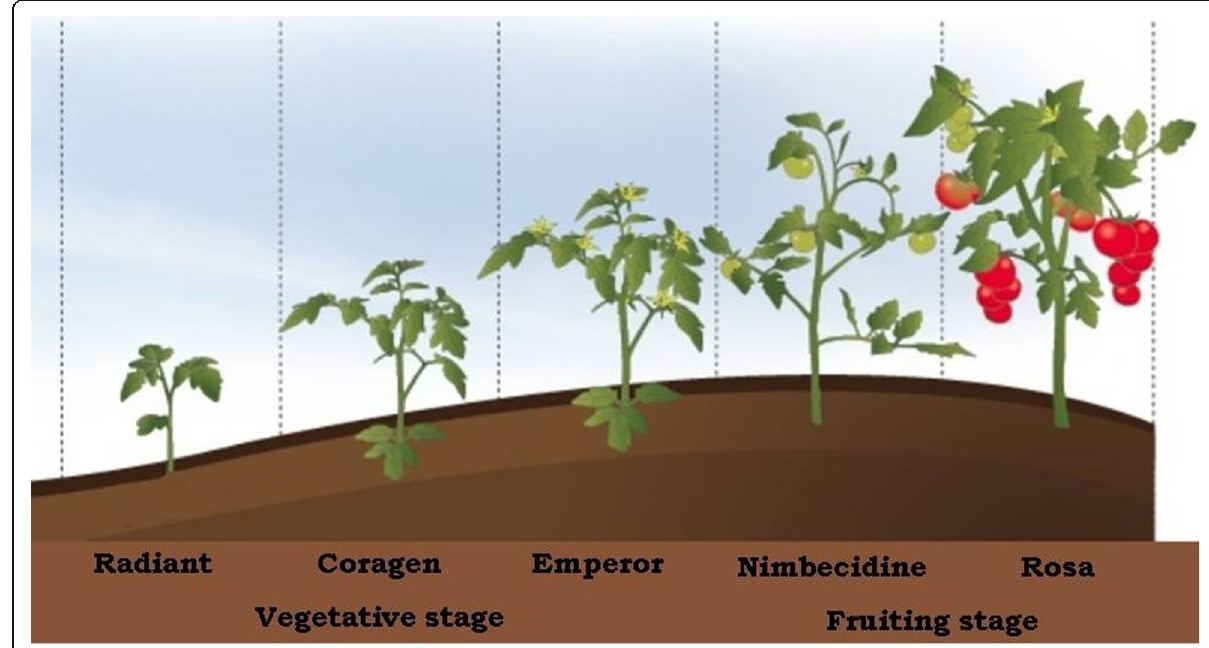
Fig. 1 Sequence of insecticides and the naturally formulations throughout the season